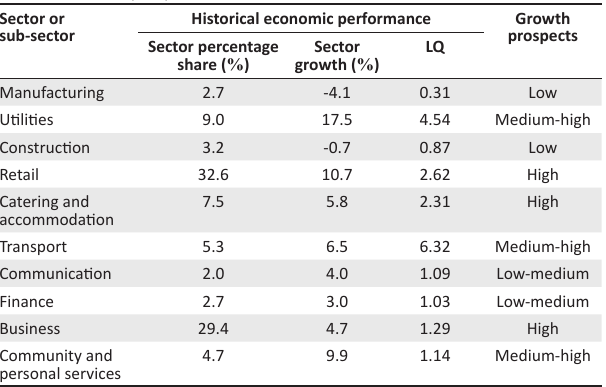
U(cid:20)li(cid:20)esConstruc(cid:20)on Manufacturing Source: Authors’ own work The CAA excludes government services sector. FIGURE 9: Leading–lagging analysis: Potchefstroom Campus within Tlokwe, 2009–2015. TABLE 2: Growth prospects of sectors that benefit. Sector or